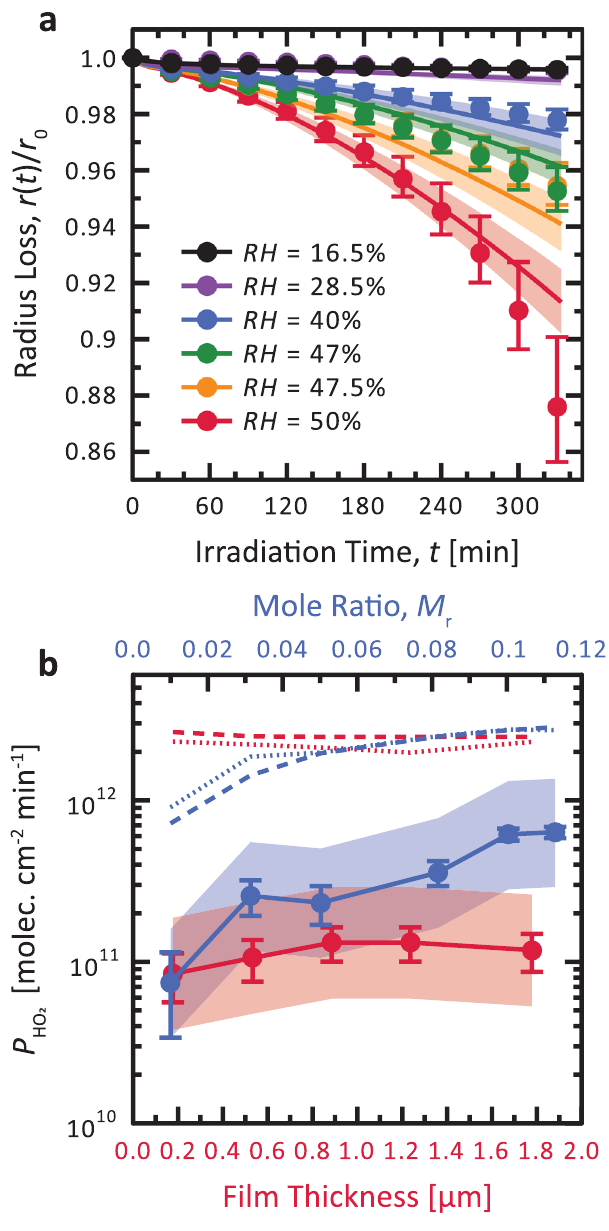
Fig. 2 Photochemical reaction in particles and fi lms. a Electrodynamic balance experiments determined that particle radius, r ( t ), decreased over time, t , during light exposure ( r = r (0)) due to the release of CO 0 2 and other volatile species. Error bars indicate the range of possible refractive index values from any changes in composition during irradiation. The solid lines were derived from the photochemical reaction and diffusion (PRAD) model, and the shading is the model sensitivity to ±2% in relative humidity, RH. b Measured steady-state production of HO 2 , P HO , from coated wall fl ow tube experiments is shown as a 2 function of the mole ratio between Fe(III)-citrate and citric acid, M r (blue), and fi lm thickness (red) indicated by symbols. Error bars indicate the standard deviation of multiple measurements or the propagated random error from solution preparation, whichever is larger. Dotted and dashed lines were determined from the PRAD model with k SR = 8.3×10 5 M − 1 s − 1 in dilute aqueous solution, or using the parameterization log k SR ¼ (cid:2) 2 : 854 ´ 10 (cid:2) 5 RH 3 þ 0 : 0024RH 2 þ 0 : 1087RH (cid:2) 0 : 05018 ; respectively 28 . Here, M is molarity in units of moleL − 1 . Solid lines were from the PRAD model using fi tted HO 2 loss rates shown in Supplementary Fig. 6. The shading is the model sensitivity to a factor of 5 uncertainty in the HO 2 loss